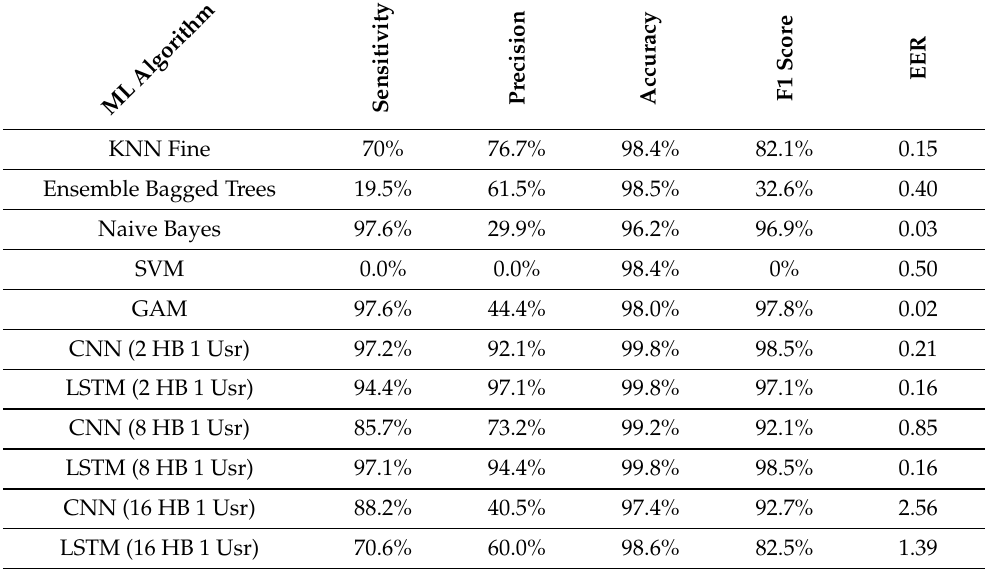
Table 8. ECG-PPG Fusion Result Details—Single User